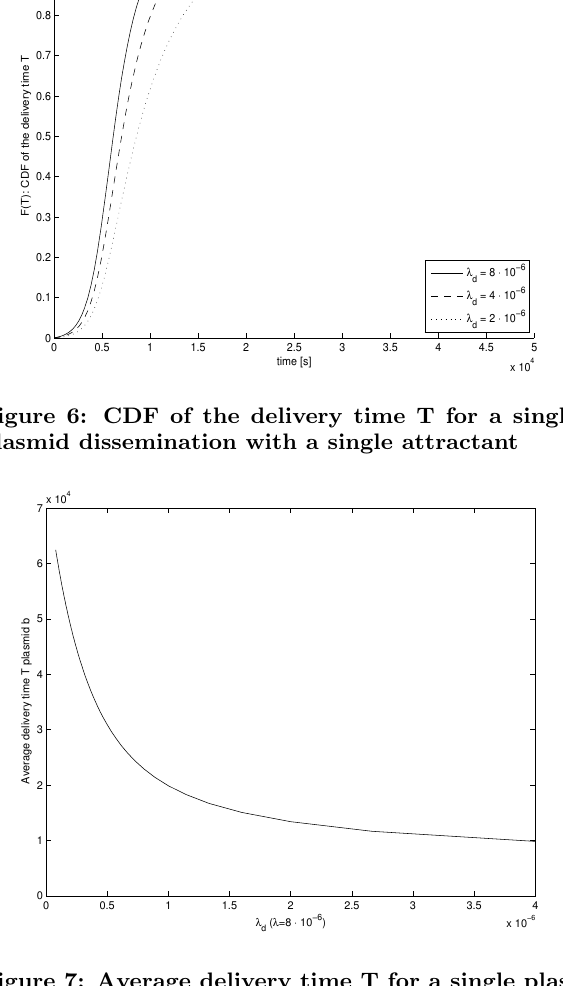
Figure 7: Average delivery time T for a single plas- mid dissemination with a single attractant suggests that the probability to deliver a packet is very low even for high number of infected nodes, but rapidly increases upon approaching the saturation of the network (number of infected nodes equal to the total number of bacteria in the environment). Finally, in Figure 8, we show the number of recovered nodes versus time. As expected the number of re- covered nodes increases in a non linear way and we observe that the proposed recovery scheme is a very slow process if compared to the diffusion of the infection.